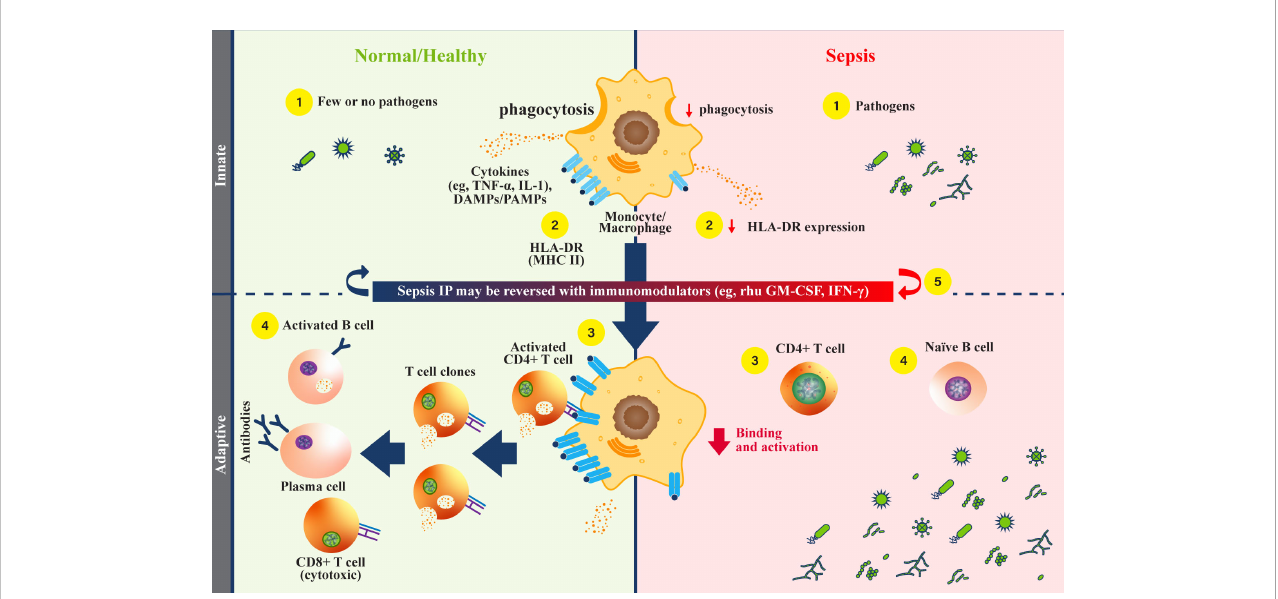
FIGURE 1 Monocytes and HLA-DR function during sepsis. (Normal/Healthy; left) (1) Innate immune cells respond to infectious pathogens by phagocytosis, cytokine secretion, and antigen presentation (1, 4). (2) Phagocytosed pathogens are broken down, then combined as peptides with class II major histocompatibility complex (MHC) (e.g., human leukocyte antigen-DR isotype [HLA-DR], and localized to the cell surface) (4, 40). (3) Peptide-MHC complexes on antigen presenting cells engage with CD4+ helper T cells to activate an adaptive immune response, triggering cytokine release (4, 40). (4) Activated CD4+ T helper cells undergo clonal expansion, activate CD8+ T cells, and mediate B cell activation (1, 26, 41). Activated B cells then differentiate into plasma cells that secrete antibodies, comprising a humoral response. (Sepsis IP; right) (1) Dysfunctional monocytes/macrophages demonstrate reduced pathogen phagocytosis, reduced antigen presentation, and variable cytokine pro fi les (4). (2) Dysfunctional monocytes/ macrophages express less antigen-bound HLA-DR proteins, leading to reduced engagement with the adaptive immune system (4). (3) Without effective antigen presentation by monocytes/macrophages, CD4+ T cells are not activated, and adaptive immune responses are rendered ineffective in clearing pathogens (1). (4) Naïve B cells are not activated by CD4+ T cells, and antibody producing plasma cells are not generated. With an inadequate humoral immune response, pathogens survive and replicate (1, 42). (5) Recombinant human (rhu) granulocyte-macrophage colony-stimulating factor (GM-CSF) may restore monocyte/macrophage function (4). DAMP, damage-associated molecular patterns; GM-CSF, granulocyte-macrophage colony-stimulating factor; HLA-DR, human leukocyte antigen-DR isotype; IFN, interferon; IL, interleukin; IP, immunoparalysis; PAMP, pathogen-associated molecular patterns; MHC II, class II major histocompatibility complex; rhu, recombinant human; TNF, tumor necrosis